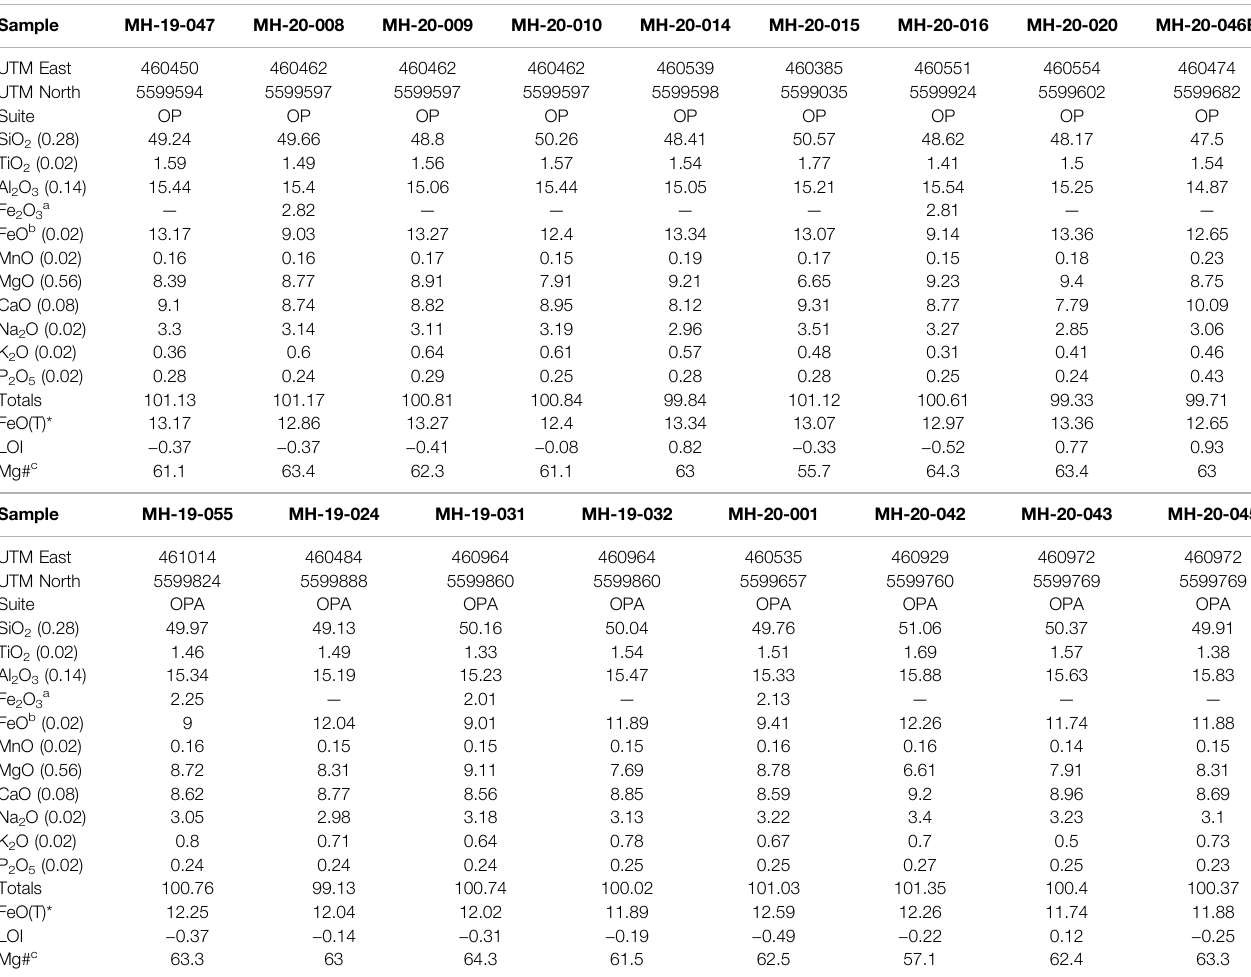
TABLE 1 | Whole-rock major (wt%) element compositions of Cracked Mountain volcanic rocks analysed by X-ray fl uorescence; analytical precision (2s) based on replicates (in brackets). Sample